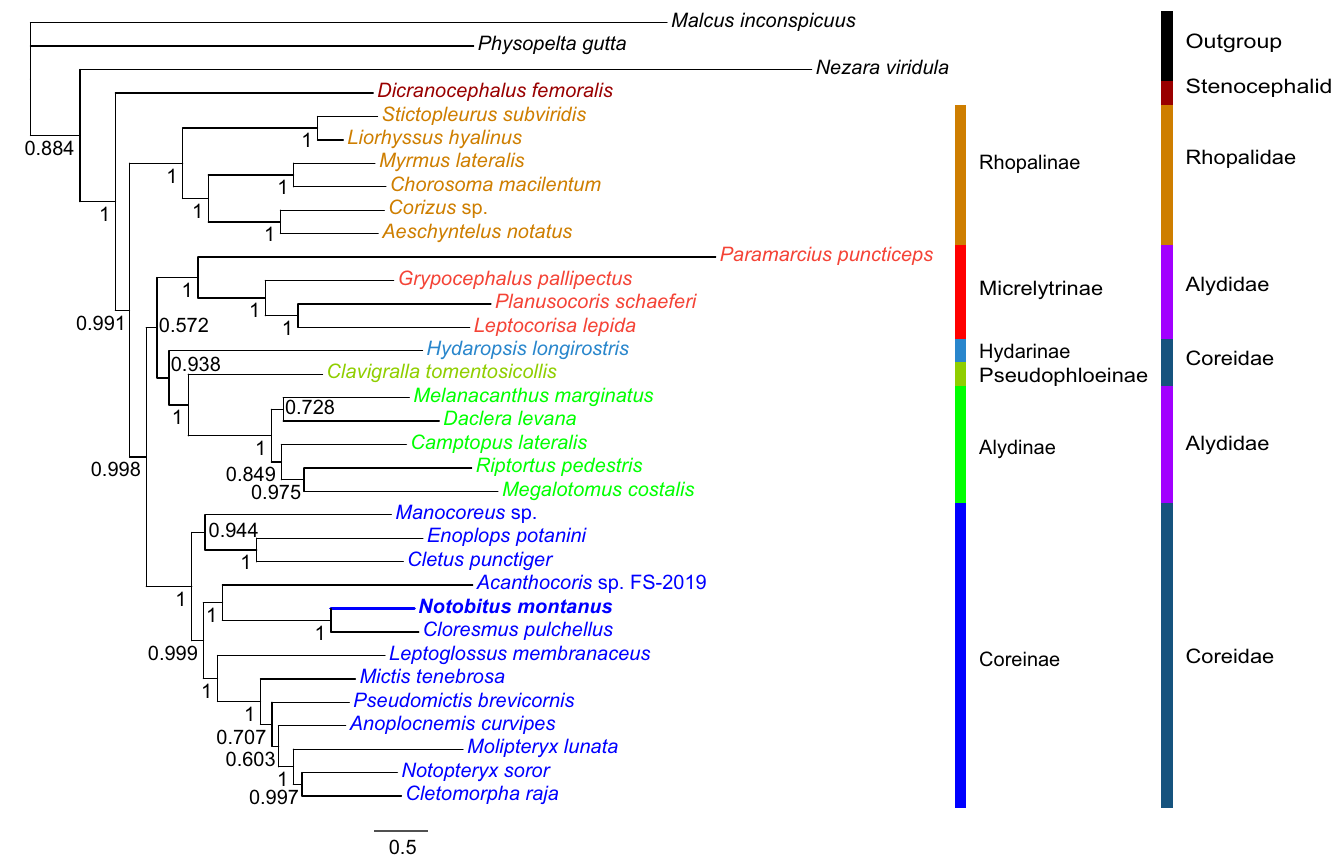
Fig 6. Bayesian phylogenetic tree of 31 Coreoidea species. The tree is constructed with nucleotide sequences of 13 mitochondrial PCGs. For family, Black, red, orange, purple and dark blue represents outgroup, Stenocephalidae, Rhopalidae, Alydidae and Coreidae, respectively. For subfamily, orange, bright red, wathet blue, green, bright green, and bright blue represents Rhopalinae, Micrelytrinae, Hydarinae, Pseudophloeinae, Alydinae, and Coreinae, respectively. The posterior probabilities were labeled at each